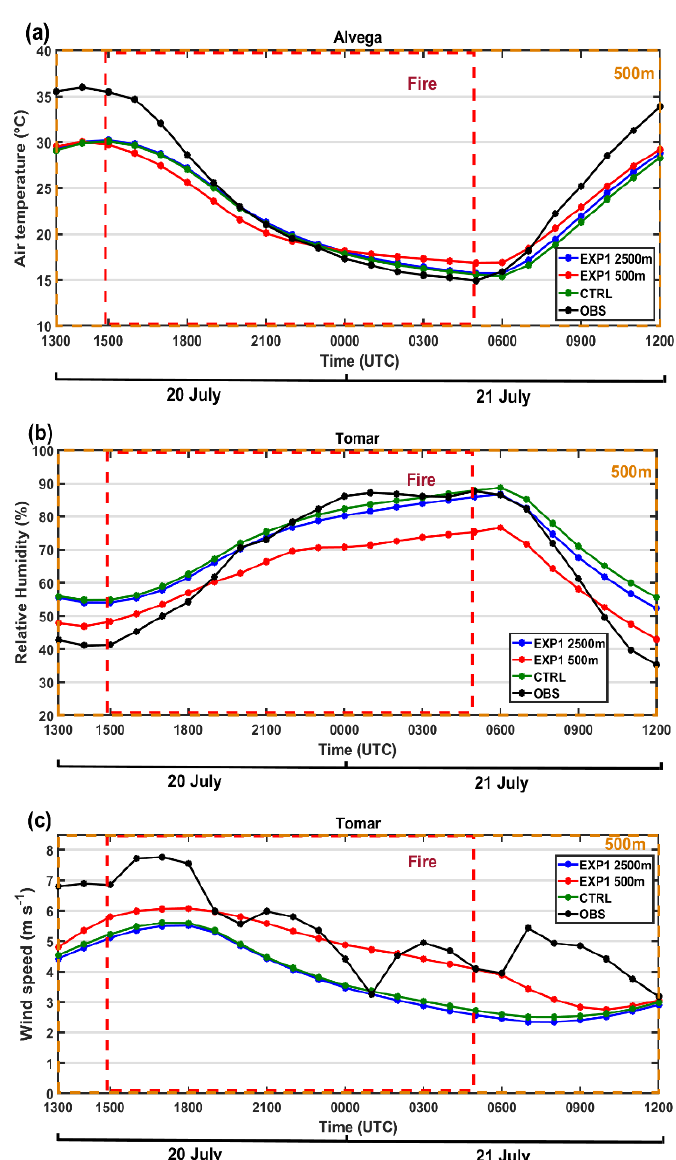
Figure 4. Comparison of the meteorological variables between the CTRL and EXP simulations with observations from the weather automatic stations during the inner domain period (orange box) and wildfire period (red box): ( a ) air temperature (°C) at 2 m in Alvega; ( b ) relative humidity (%) at 2 m in Tomar, and ( c ) wind speed (m s − 1 ) at 10 m in Tomar.